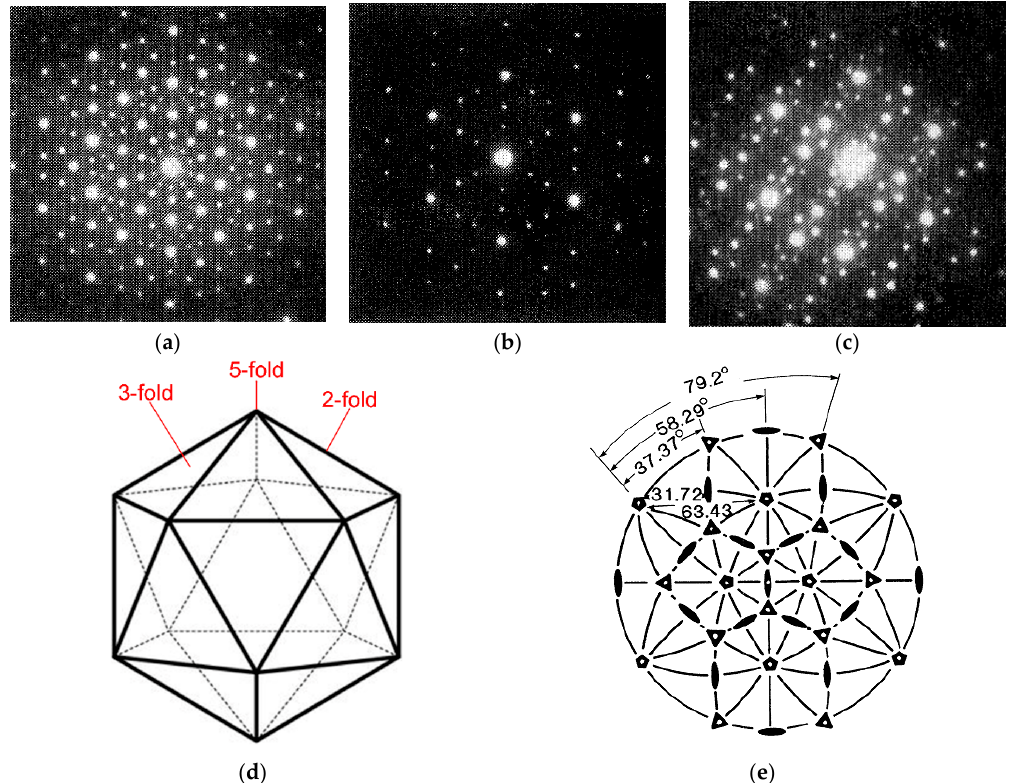
Figure 1. Icosahedral structure: SAED patterns taken along ( a ) 5-fold symmetry axis; ( b ) 3-fold symmetry axis and ( c ) 2-fold symmetry axis; ( d ) three types of symmetry axes in the icosahedral structure; ( e ) stereographic projection of the symmetry elements of the icosahedral group (( a – e ) reproduced from reference [1] with permission).